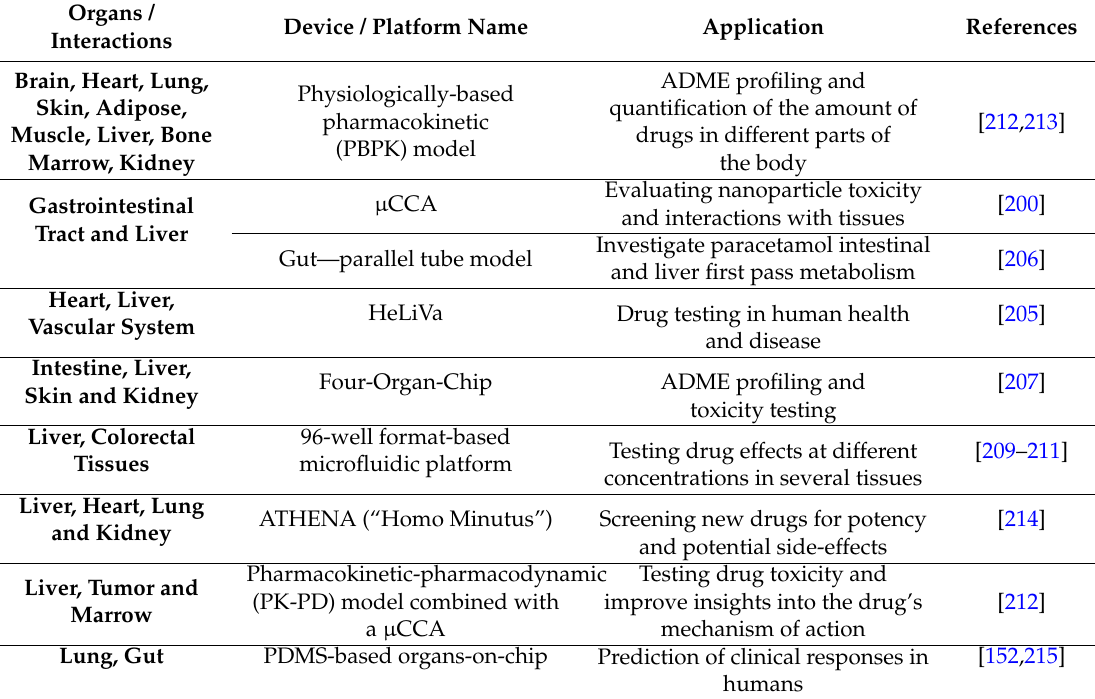
Table 2. Available BoCs and their